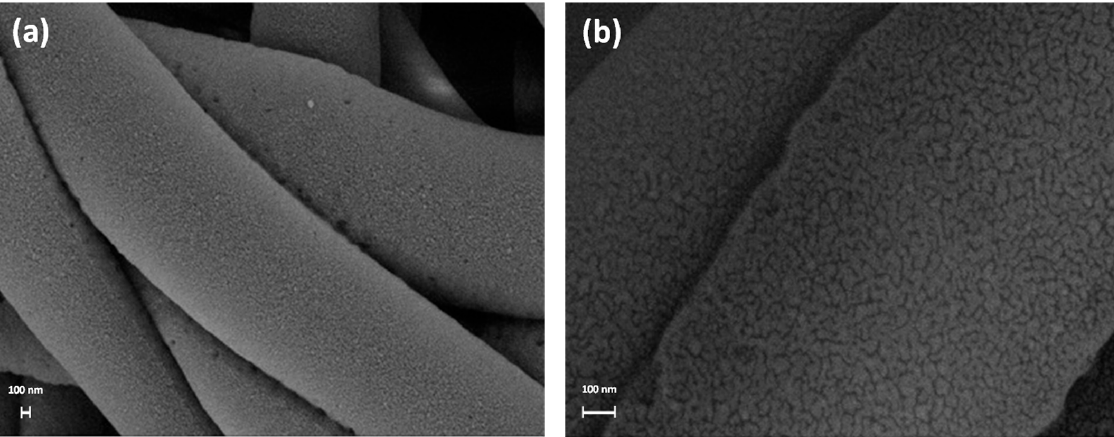
Figure 6 . SEM micrographs at high magnification ( a ) 50K× and ( b ) 200K× of the Ag-coated PSU fibers.